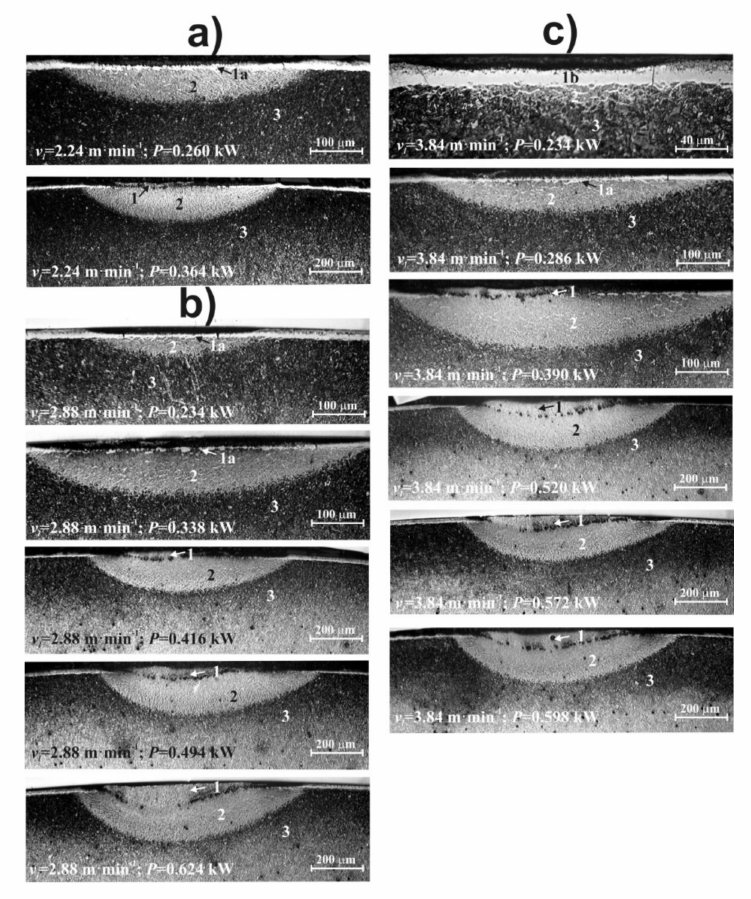
Figure 3. OM images of single laser tracks produced on gas-nitrided 42CrMo4 steel using a scanning rate of 2.24 m · min − 1 ( a ); 2.88 m · min − 1 ( b ); and 3.84 m · min − 1 ( c ); 1—re-melted zone (MZ), 1a—partially re-melted compound zone, 1b—compound zone without visible e ff ects of remelting, 2—heat-a ff ected zone (HAZ), 3—nitrided layer without visible e ff ects of LHT (di ff usion